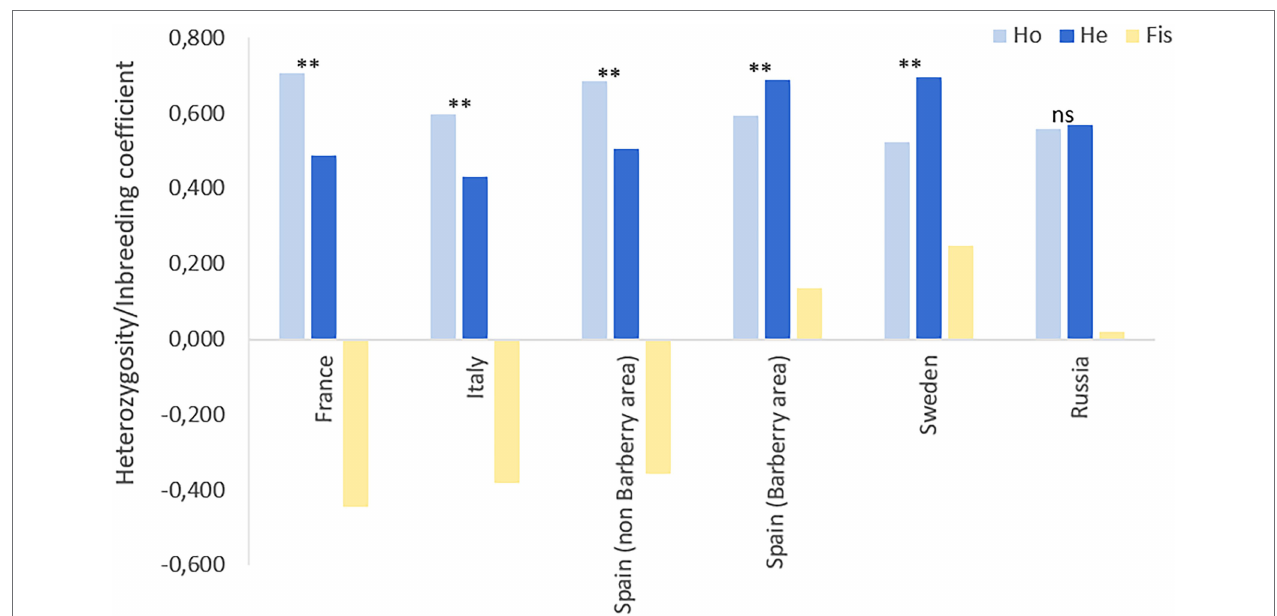
FIGURE 3 | Observed heterozygosity (H o ), expected heterozygosity (H e ) and inbreeding coefficients (F is ) of geographical spaced populations of Puccinia graminis f. sp . tritici in Europe and Siberia. Samples from outside these areas were not considered due to low sample sizes in individual countries. Level of significance: p < 0.01**.